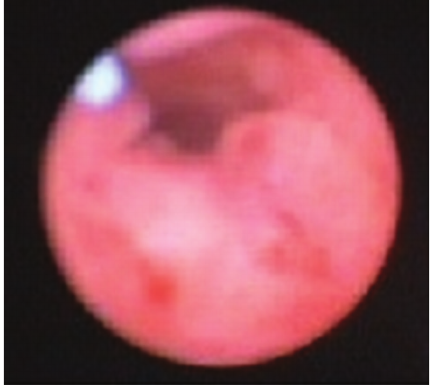
Figure 2: View of the ureter before intraurethral BCG treatment.